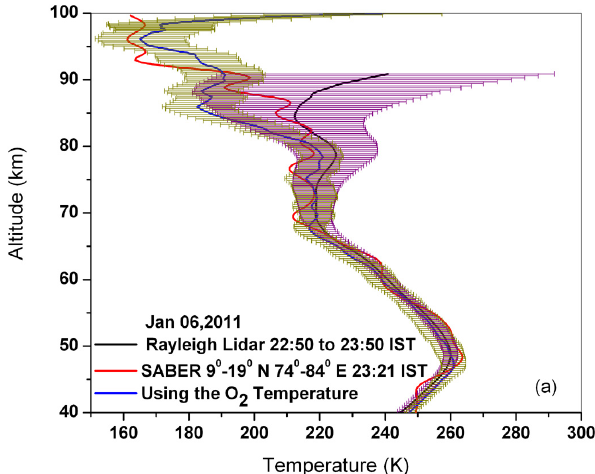
Fig. 1b. The individual SABER profiles in the used grid. It is ev- ident that large amplitudes of wave structures make significant dif- ference within a narrow latitude-longitude